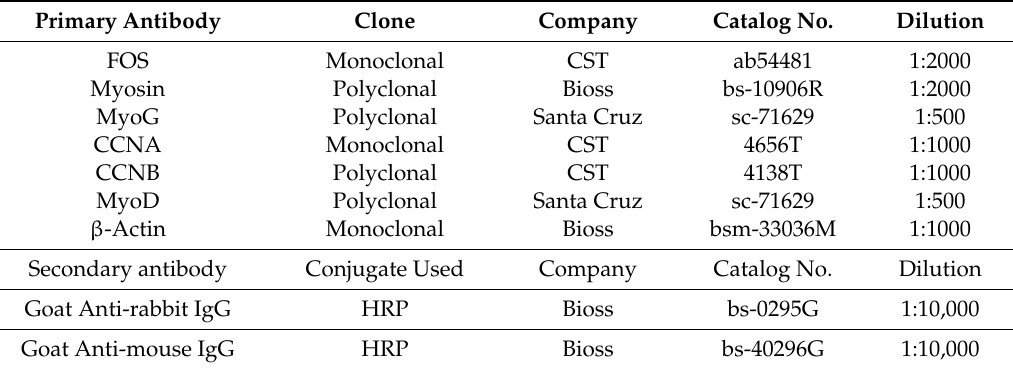
Table 2. The antibodies used in this